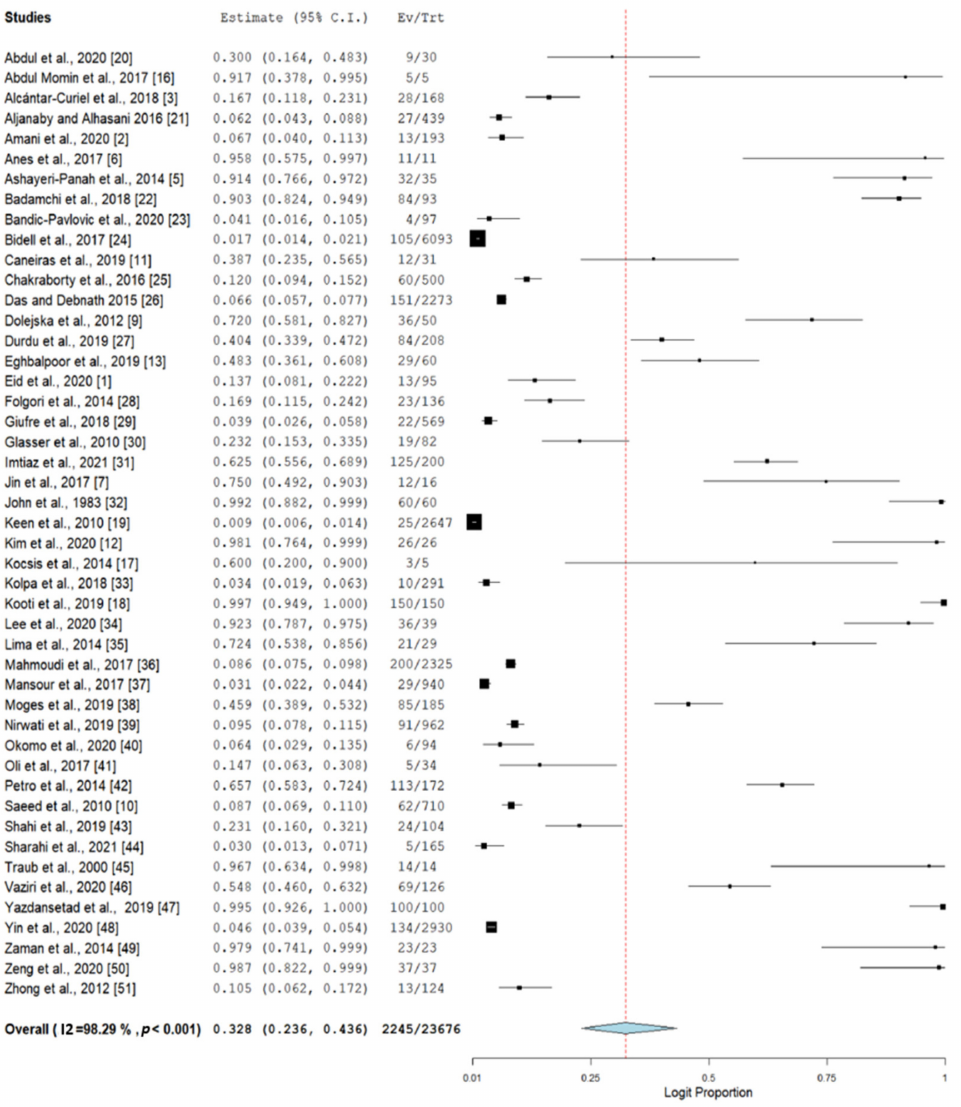
Figure 3. Forest plot of the prevalence of nosocomial MDR K. pneumoniae . The prevalence of reported nosocomial MDR K. pneumoniae cases was estimated by a random-effect model using the DerSimonian-Laird method of